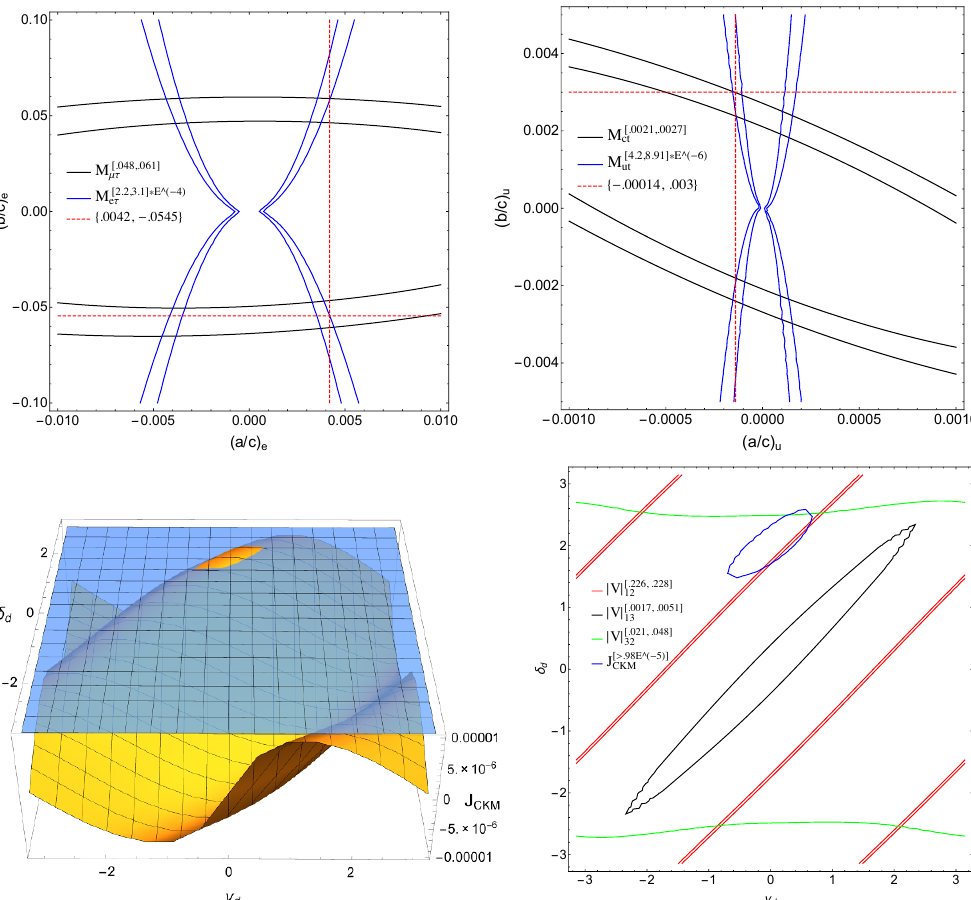
Figure 1 . Contours from our lowest order (cid:12)t. Top left : contours of the charged lepton mass (cid:12)t. Black contours represent the bounds for the ratio of m (cid:22) =m (cid:28) whereas blue contours represent those for m e =m (cid:28) , both taken from [34]. The plot is at a (cid:12)xed m (cid:28) =m (cid:28) = 1. Red dashed lines represent our solution. Top right : the same, but for up quarks. Bottom left : the contours of the Jarlskog Invariant over the plane of the two free phases left in this (cid:12)t after (cid:12)xing the mass ratios ( a; b ) e;u . The blue plane represents the minimum J CKM allowed in [34], and it is clear that portions of the parameter space (our solutions) can (cid:12)t this. Bottom right : contours of acceptable values of j V ij j CKM and the CKM Jarlskog (interior of blue circle), also after (cid:12)xing ( a; b ) e;u . The red line is the Cabibbo angle, and regions exterior to the black circle re(cid:13)ect acceptable values for the (1,3) element. The relative magnitudes of the (1,3) and (3,1) elements are not successfully resolved at lowest order in our (cid:12)t. Higher order corrections as discussed in the text remedy